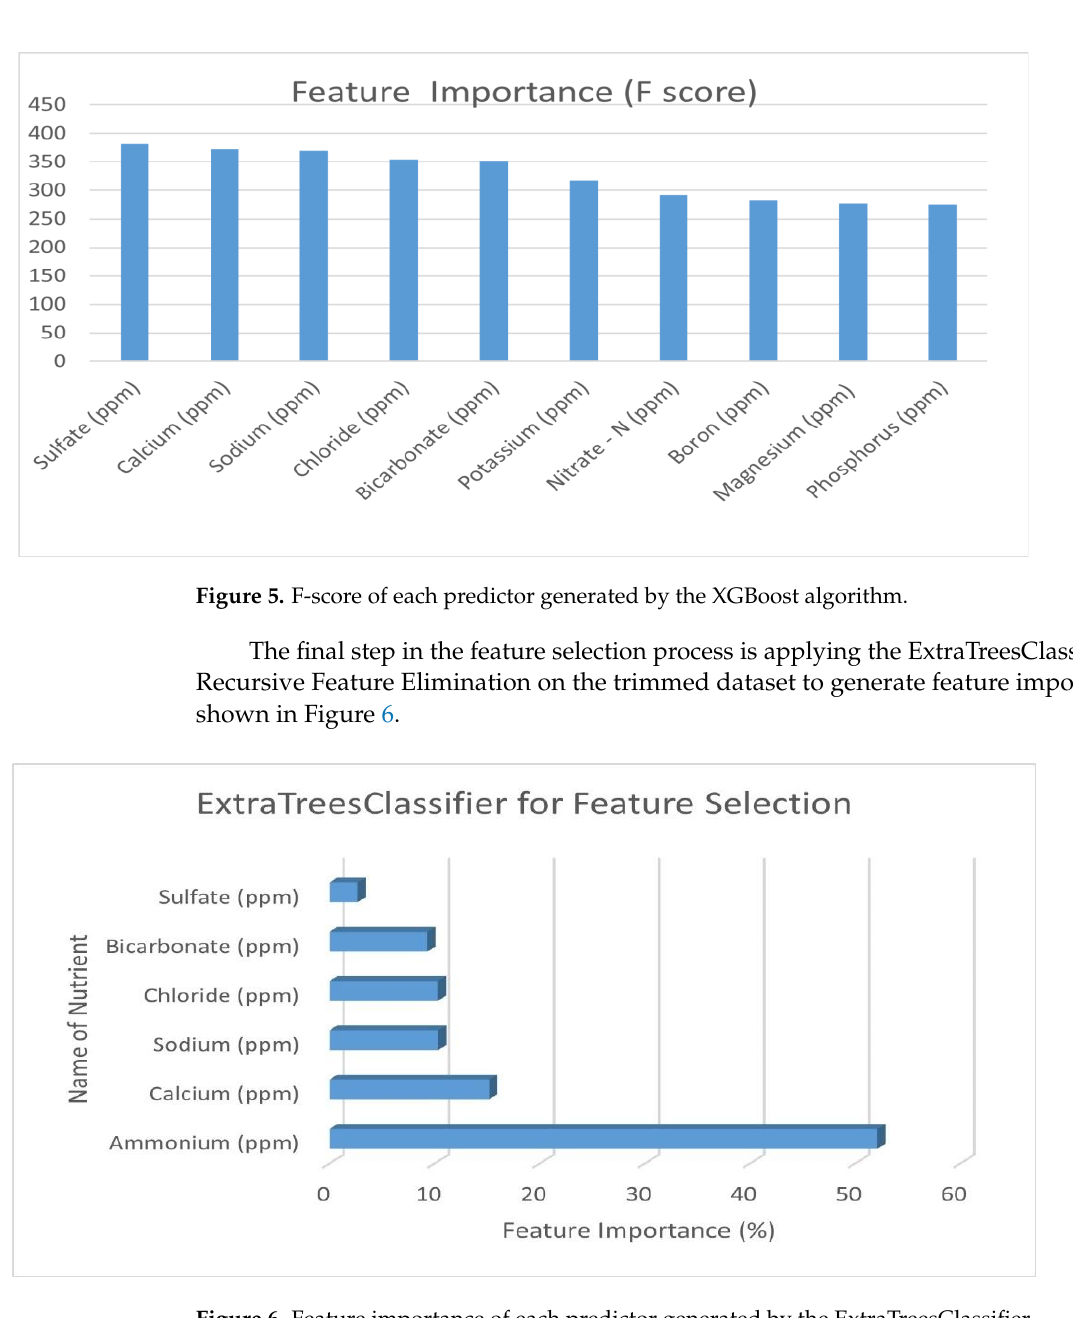
Figure 6. Feature importance of each predictor generated by the ExtraTreesClassifier .